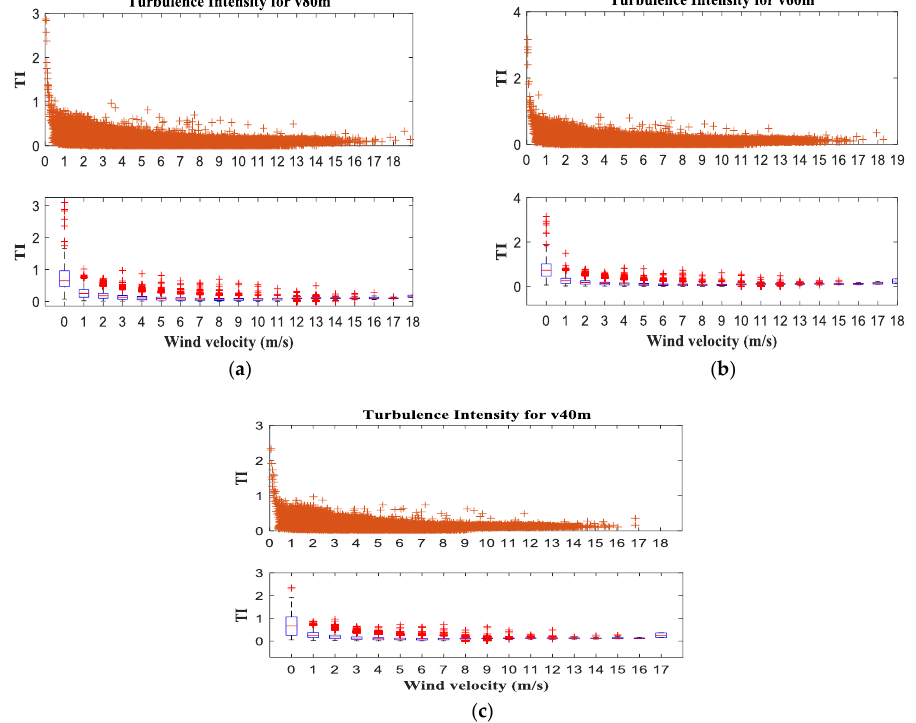
Figure 9. Turbulence intensities for velocities at different heights ( a ) 80 m ( b ) 60 m and ( c ) 40